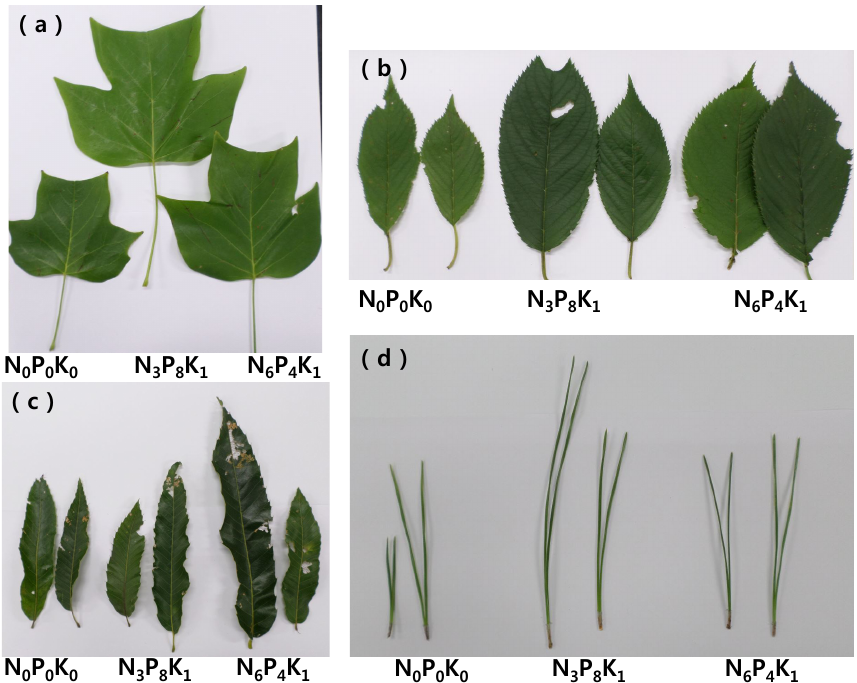
Figure 2. Morphological characteristics of foliage by fertilizer compound ratios of tree species collected on August 2014: ( a ) Liriodendron tulipifera L.; ( b ) Prunus yedoensis Matsumura; ( c ) Quercus acutissima Carruth; and ( d ) Pinus thunbergii